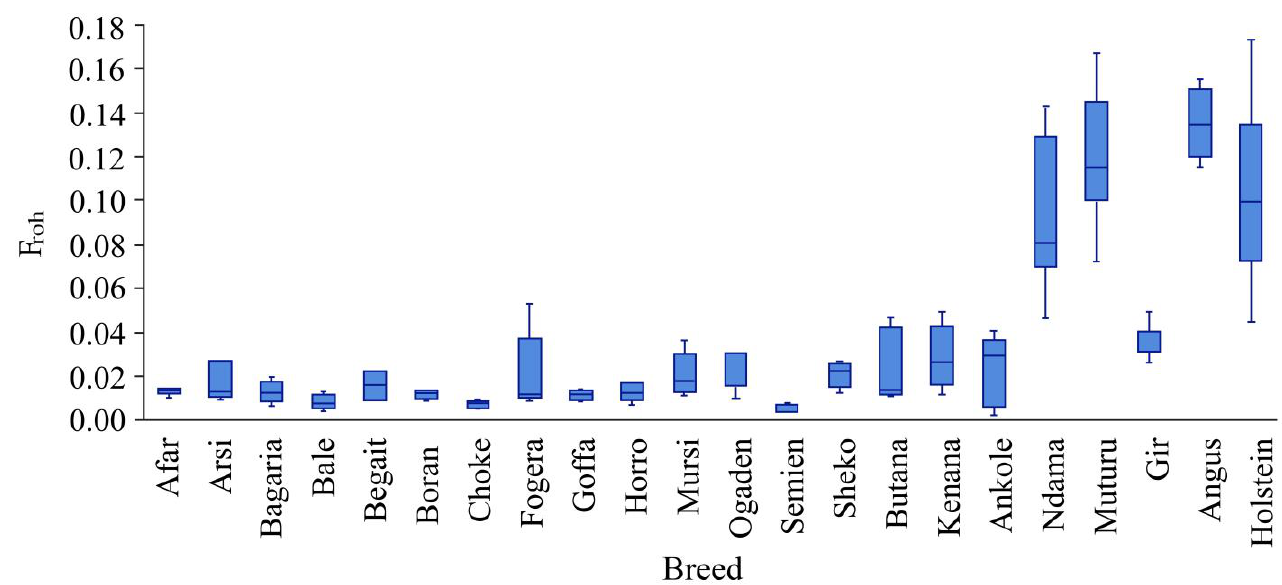
Figure 5. Box plot of ROH-based genomic inbreeding coefficients ( F roh ) at ROHs ≥ 0.5 Mb in Ethiopian and non-Ethiopian cattle populations.